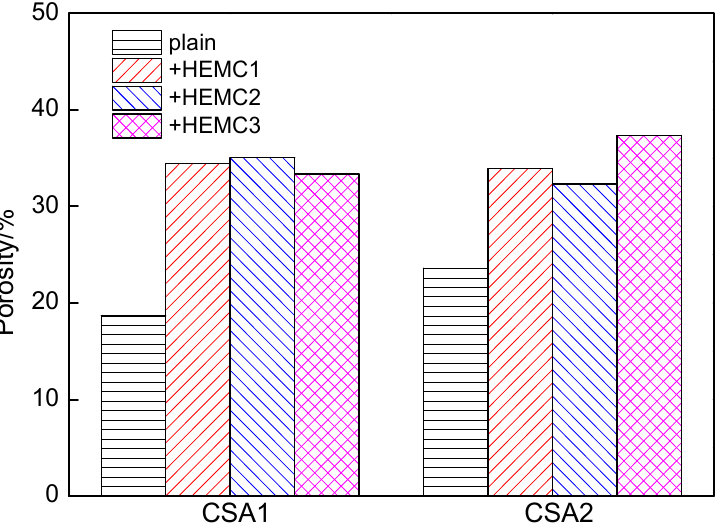
Figure 8. The porosity of CSA cement mortars with and without HEMCs at 28 days. There was no significant difference in porosity among the six HEMC-modified cement mortars, but some strengths of the mortars were different, especially the flexural strength and tensile bond strength. It was found that the formation of a CE-bridge between Ca(OH) 2 crystals probably had a contribution on the improvement of flexural strength of Portland cement mortar [46–48]. But the dosage of CE in the literature is 0.7% higher than that in this investigation. The reason why HEMCs with different MS/DS and PAAm modifications have different impacts on the flexural strength and especially tensile bond strength of CSA cement mortar needs to be further